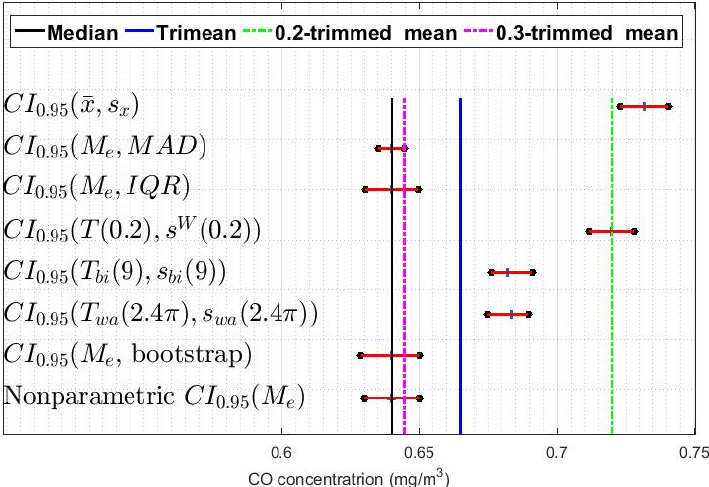
Figure 9. 95% confidence intervals ( CI 0.95 ) for X 9 ( 2016 ) : classic, nonparametric, bootstrap, and robust confidence intervals.